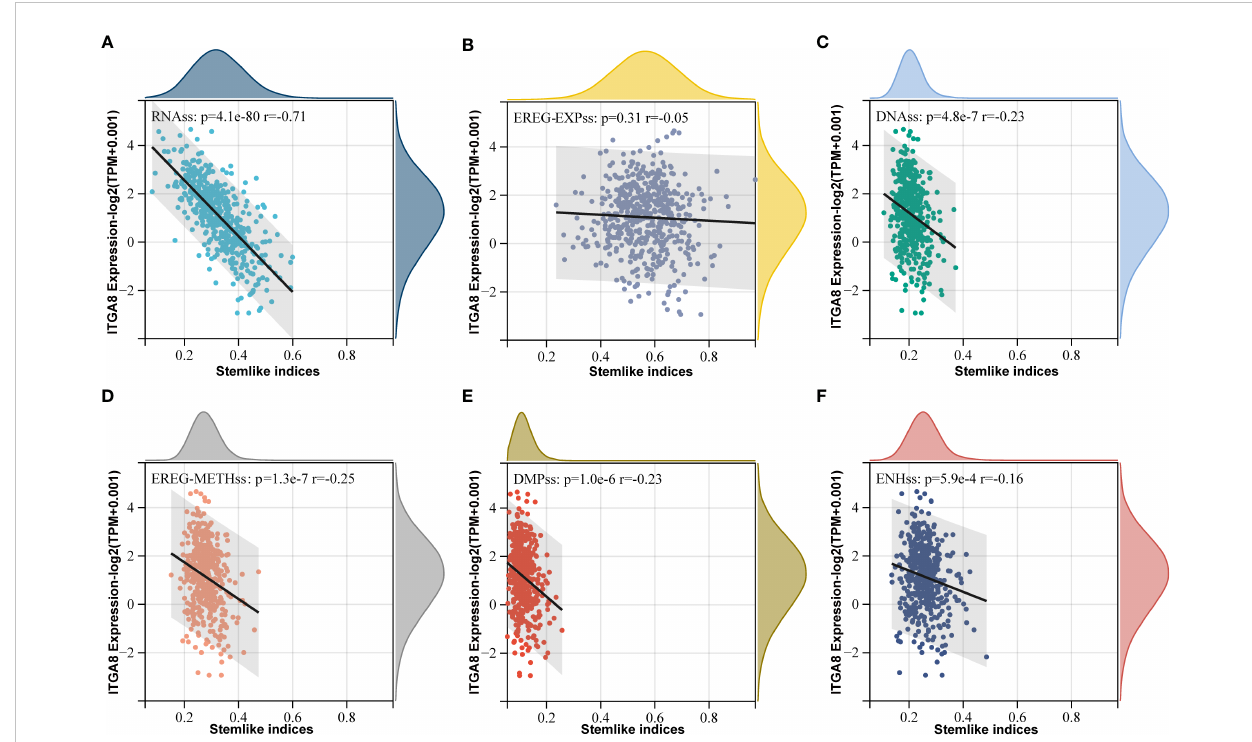
FIGURE 4 ITGA8 and cancer cell stemness. Correlation analyses between six tumor stemness scores and the gene expression data of ITGA8. (A) RNAss ( r = − 0.71, p < 0.001). (B) EREG-EXPss ( r = − 0.05, p = 0.31). (C) DNAss ( r = − 0.23, p < 0.001). (D) EREG-METHss ( r = − 0.25, p < 0.001). (E) DMPss ( r = − 0.23, p < 0.001). (F) ENHss ( r = − 0.16, p < 0.001). The expression level of ITGA8 gene was marked as Log 2(TPM+0.001)